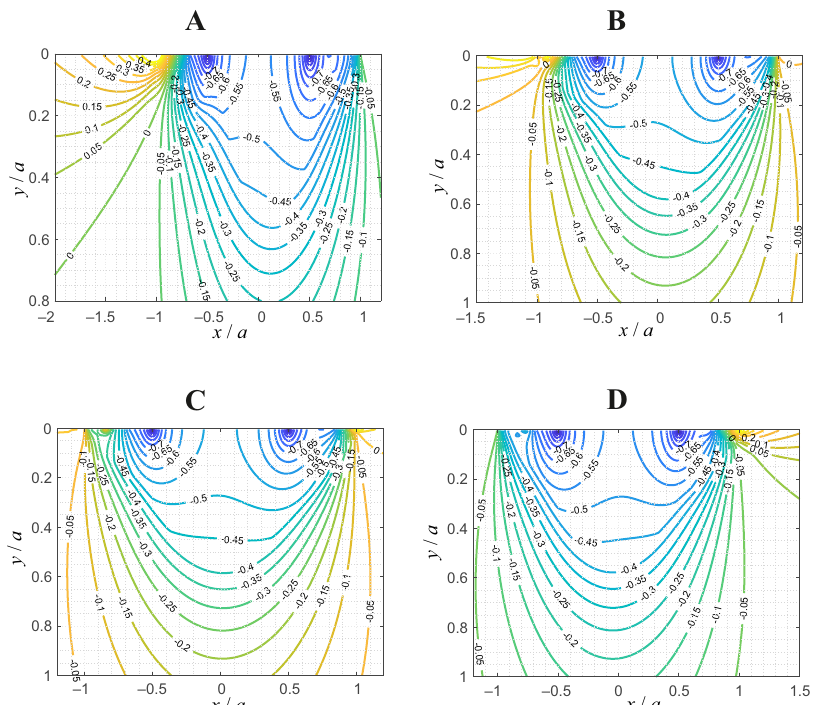
Figure 7. Contour line diagram of the largest principal stress, normalized for the average contact pressure P / ( 2 a ) , in the oscillating tangential contact with a truncated cylinder, as a function of x / a and y / a , for b = 0.5 a , Q max = 0.6 µ P , µ = 0.5 and ν = 0.3; for the points ( A ), ( B ), ( C ), and ( D ) of the loading diagram in Figure 4 (each subfigure corresponds to the respective point in the loading